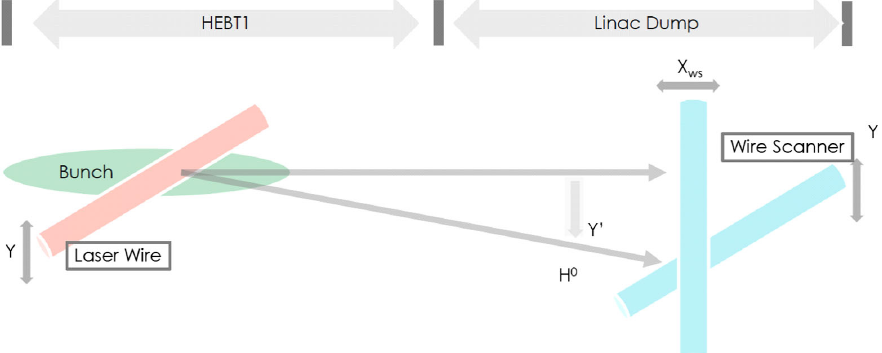
FIG. 1. Schematic of the laser wire station in the SNS